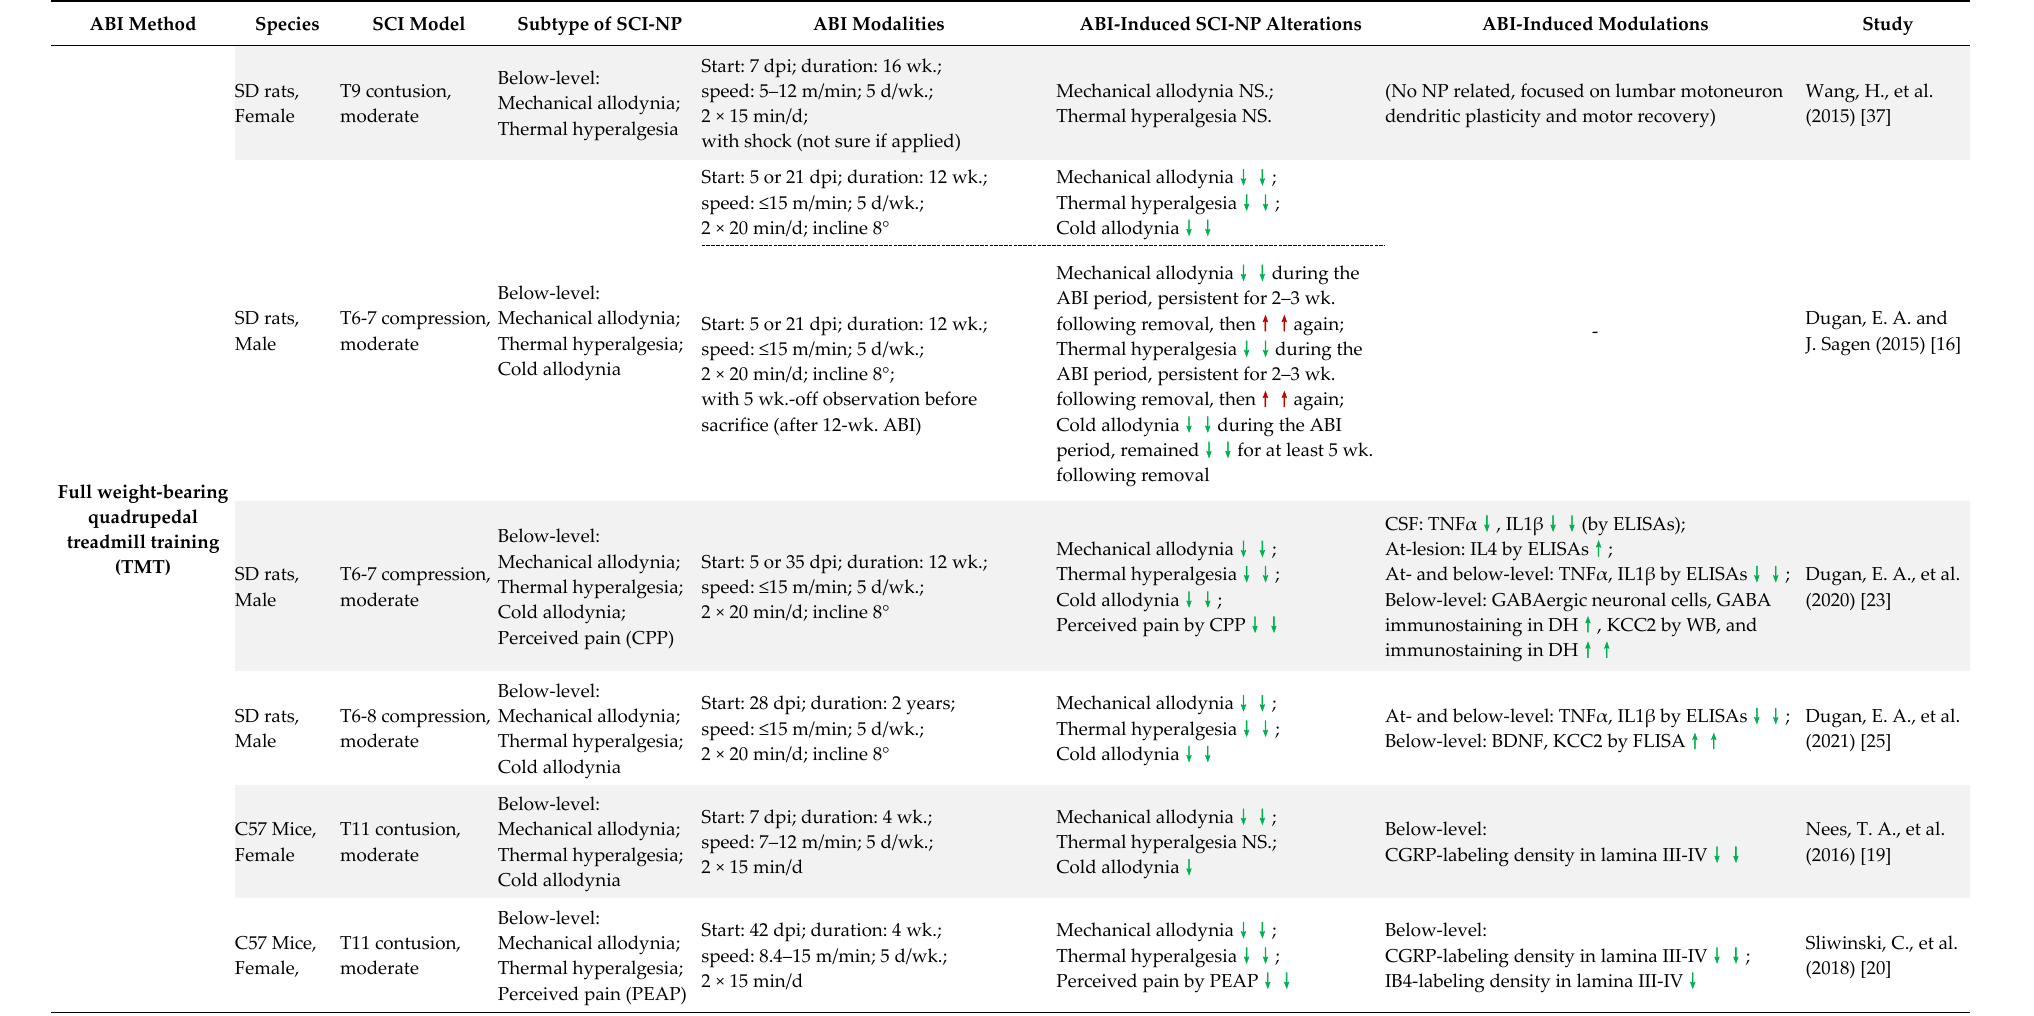
Table 1. Preclinical studies examining the effect of ABI on spinal cord injury-induced neuropathic pain (SCI-NP).